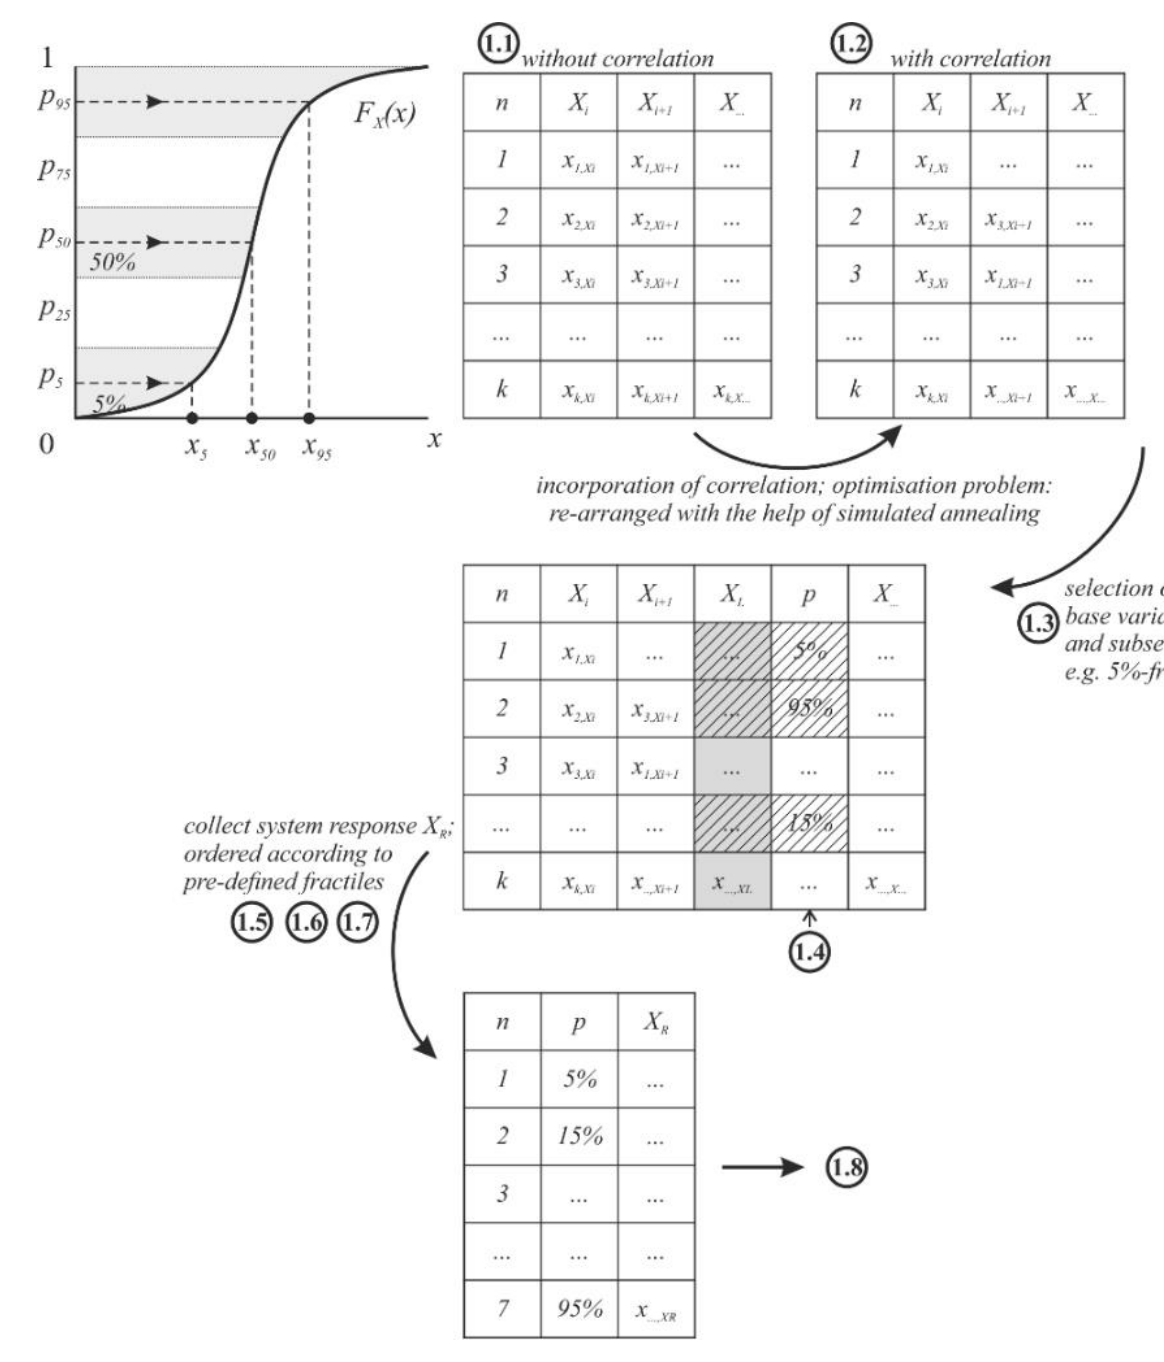
Figure 3. Fractile Based Simulation (FBS) method procedure including and not including correlation between basic variables — including the process steps.